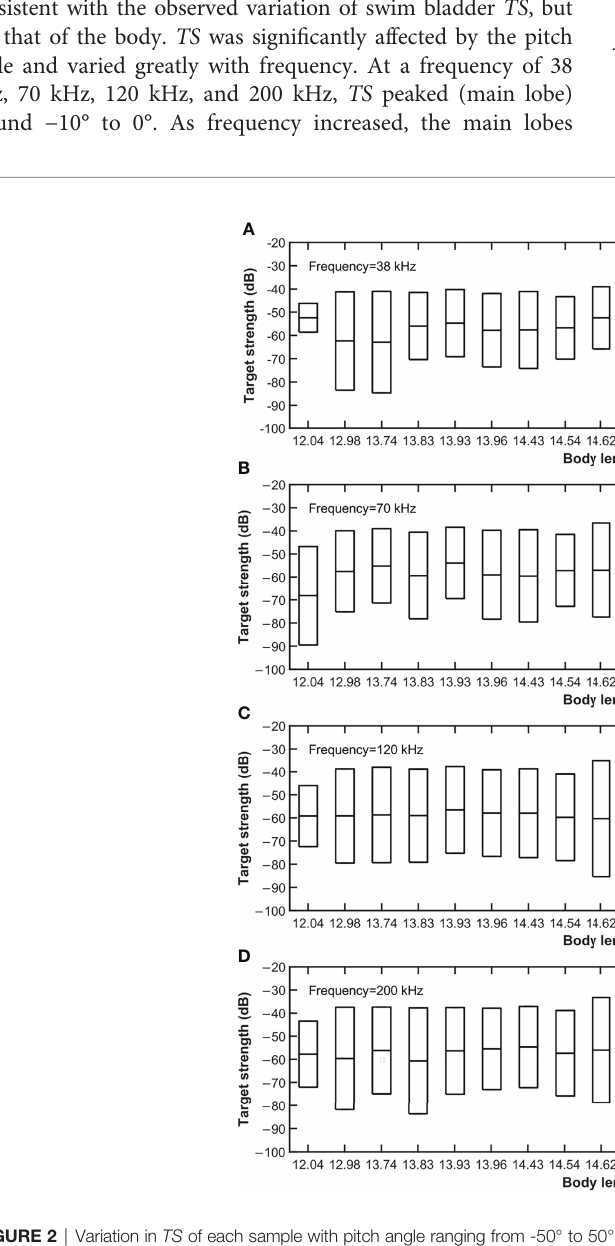
FIGURE 2 | Variation in TS of each sample with pitch angle ranging from -50° to 50°. Using Δ TS, the difference between the maximum TS and the minimum TS, to represent the variation values. The range of Δ TS was: (A) 12.33 – 52.68 dB at 38 kHz; (B) 28.81 – 45.34 dB at 70 kHz; (C) 26.38 – 52.30 dB at 120 kHz; (D) 28.57 – 50.15 dB at 200 kHz. Top and bottom edges of the box represent maximum and minimum values of TS, respectively. The middle line is the half of Δ